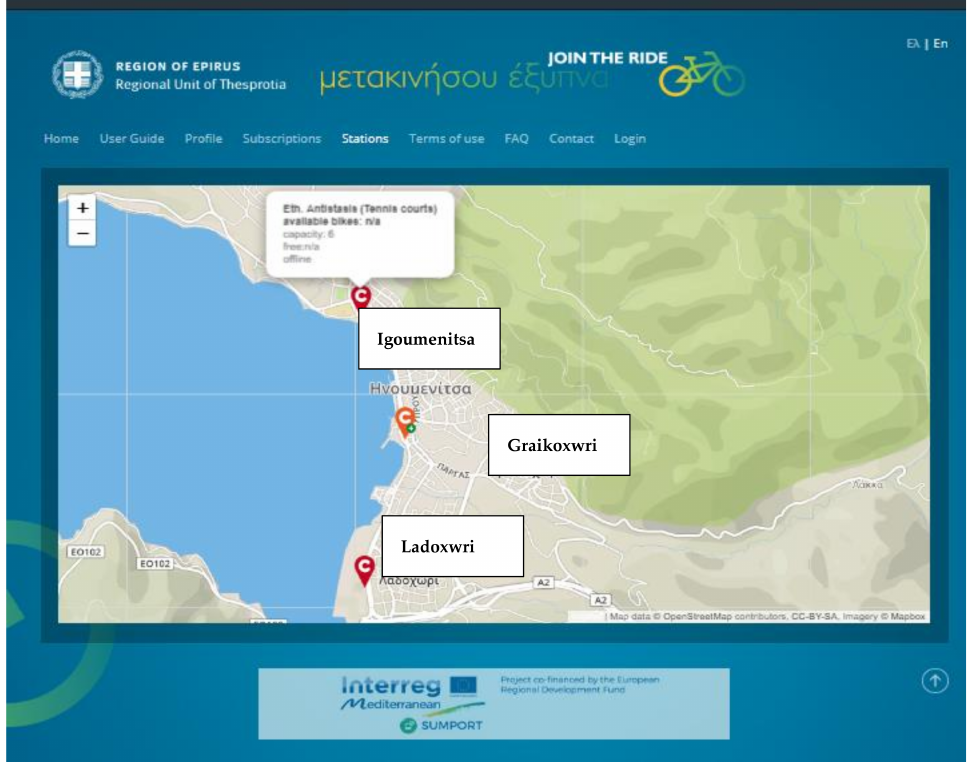
Figure 1. Interactive and real time informative map of the new bike-sharing system in the city of Igoumenitsa